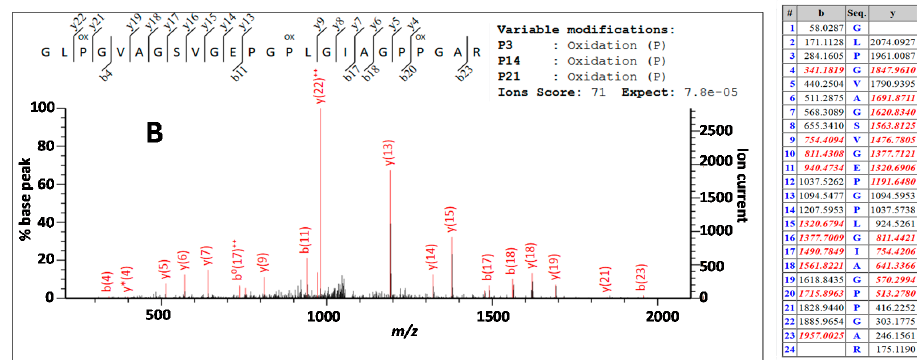
Figure 6. Example tandem mass spectra taken from Mascot output showing matches (numbers coloured red) to the same collagen peptide (2t69) but with ( A ) a variable hydroxylation matched on the 12th residue, compared with ( B ) a variable hydroxylation on the 14th residue (the peptide significance score for this ( Bos ) search was 40 and the highest false positive ion score as 31; the false discovery rate above identity threshold was 2.27%).